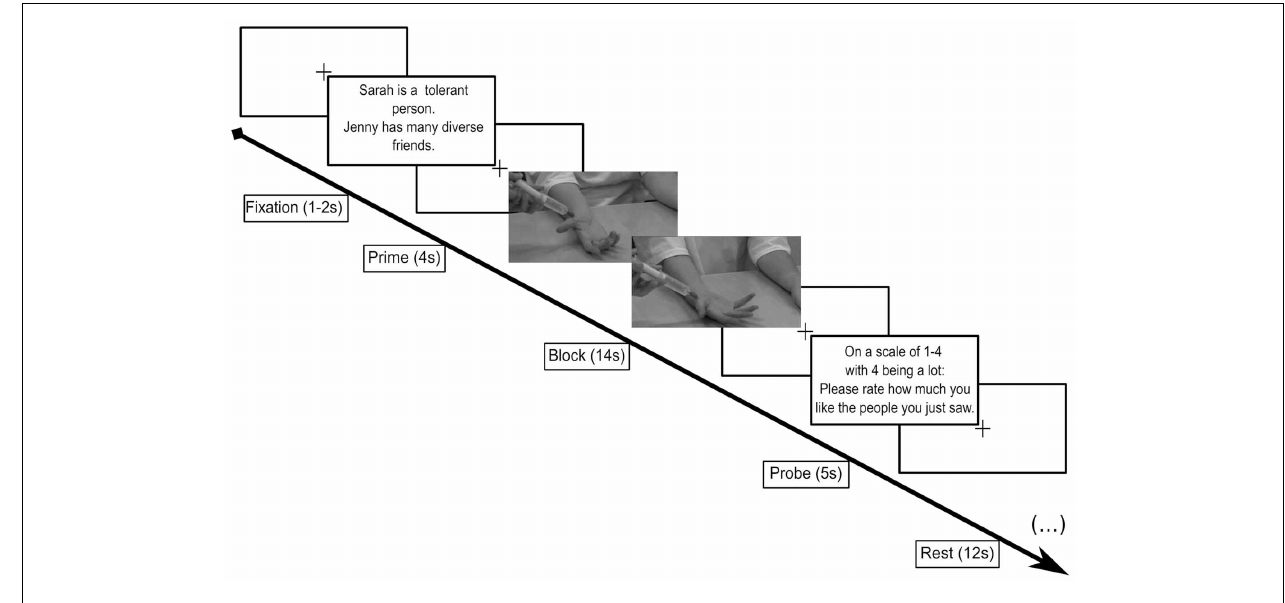
FIGURE 1 | Scanner paradigm. Subjects viewed a cue screen reminding them which targets they were about to be see (4s), followed by a video (14s) showing the face of the target then zooming to the target’s right hand as it received either an injection from a syringe (pain) or a touch from a q-tip